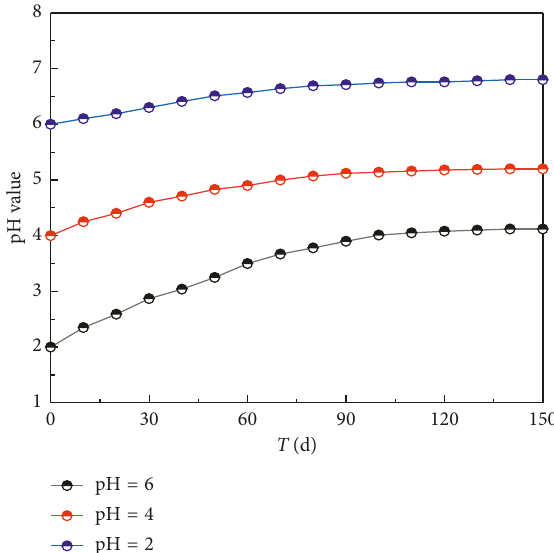
Figure 3: Time-varying curve of pH value of chemical solution.